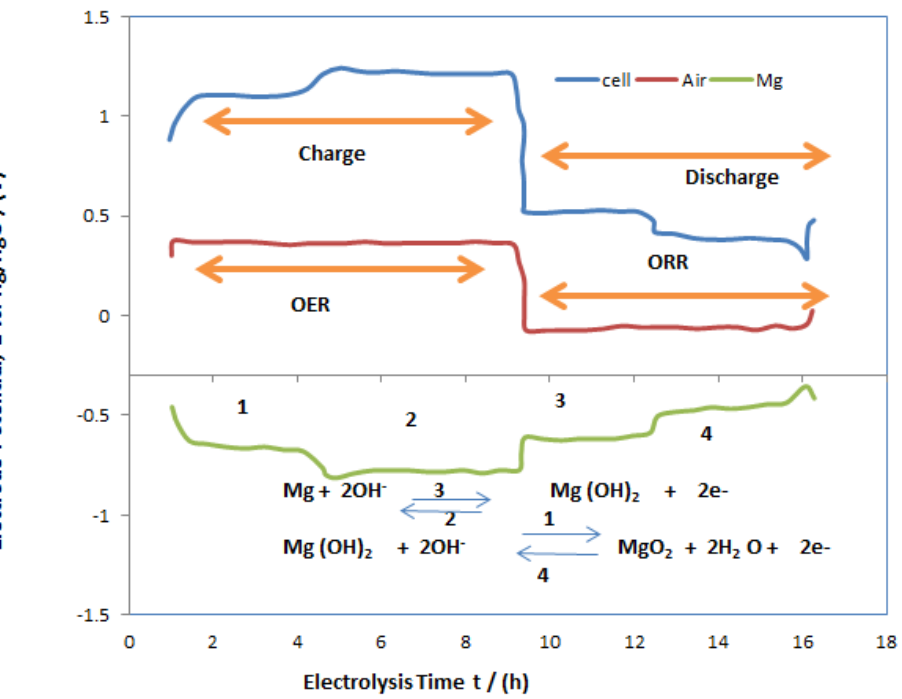
Figure 5. Cycling for discharge profile of the MAB after cycling at 17 mA cm − 2 for 17 h at 7, 13, 17, 23 and 25 mA cm − 2 current densities with an air inlet flow of 0.5 dm 3 min − 1 .